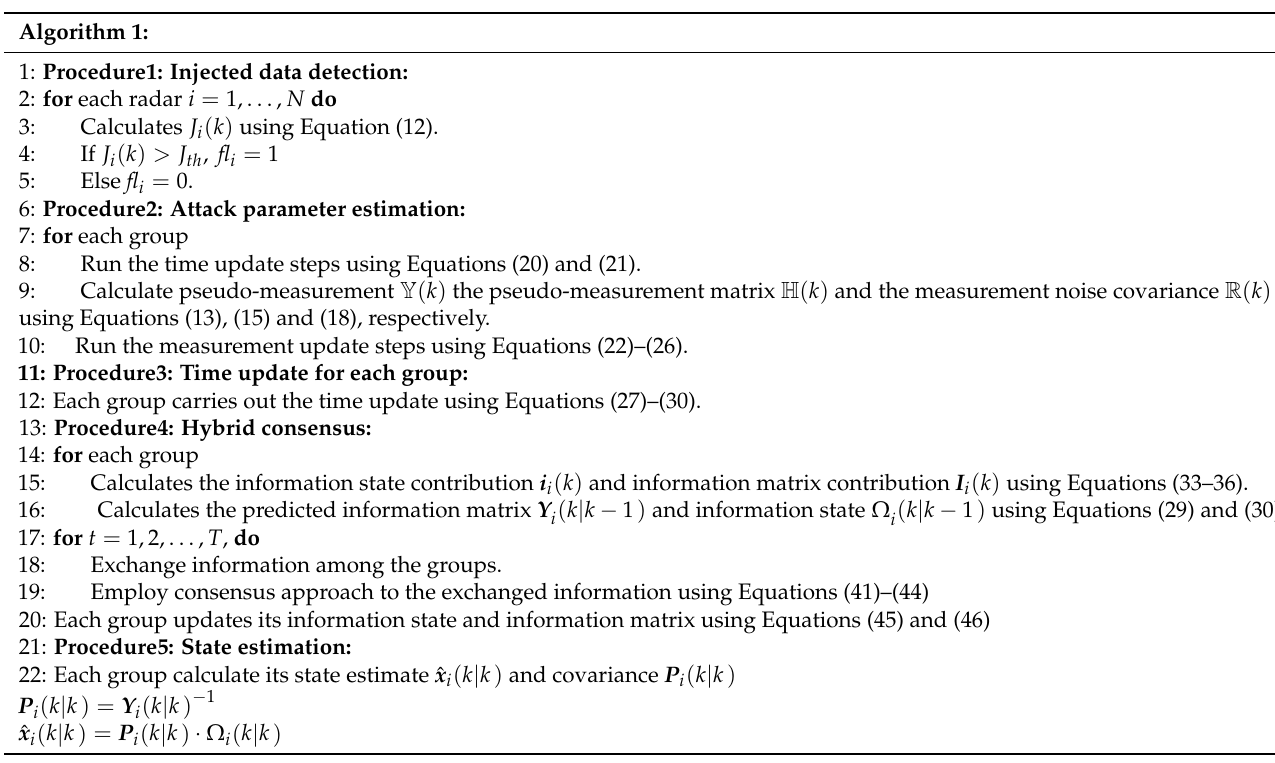
Table 1. The proposed DSE algorithm with FDI